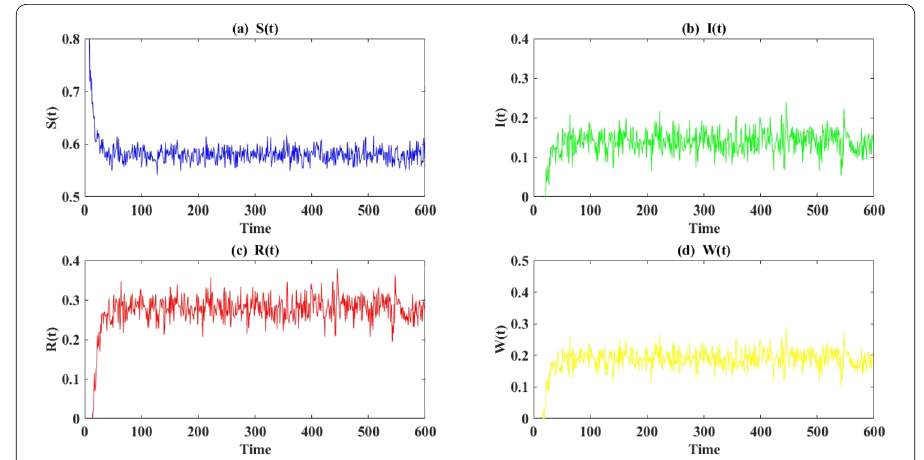
Figure 1 Existence of the endemic equilibrium and permanence in mean almost surely. Parameter values: λ = 0.01, m 1 = 0.3 and m 2 = 0.15